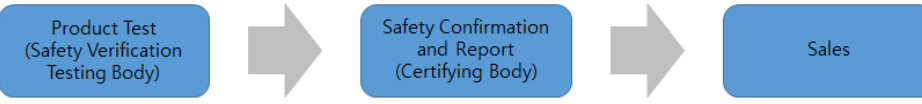
Figure 3. Safety Verification and Certification Procedure.